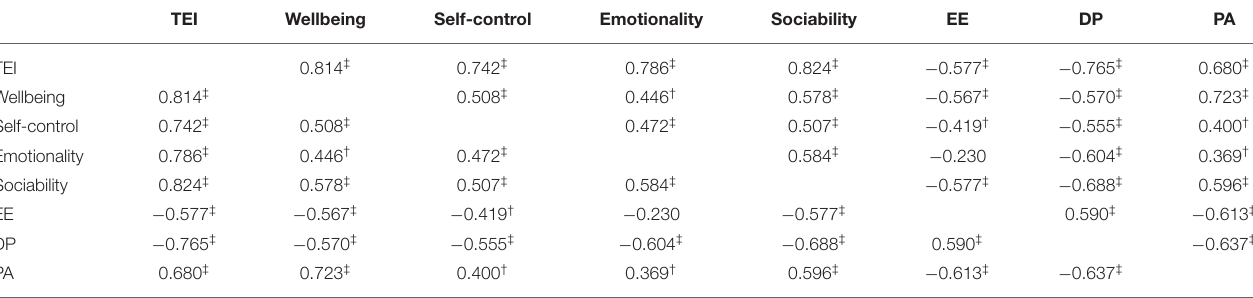
TABLE 2 | Correlations among emotional intelligence and burnout components.